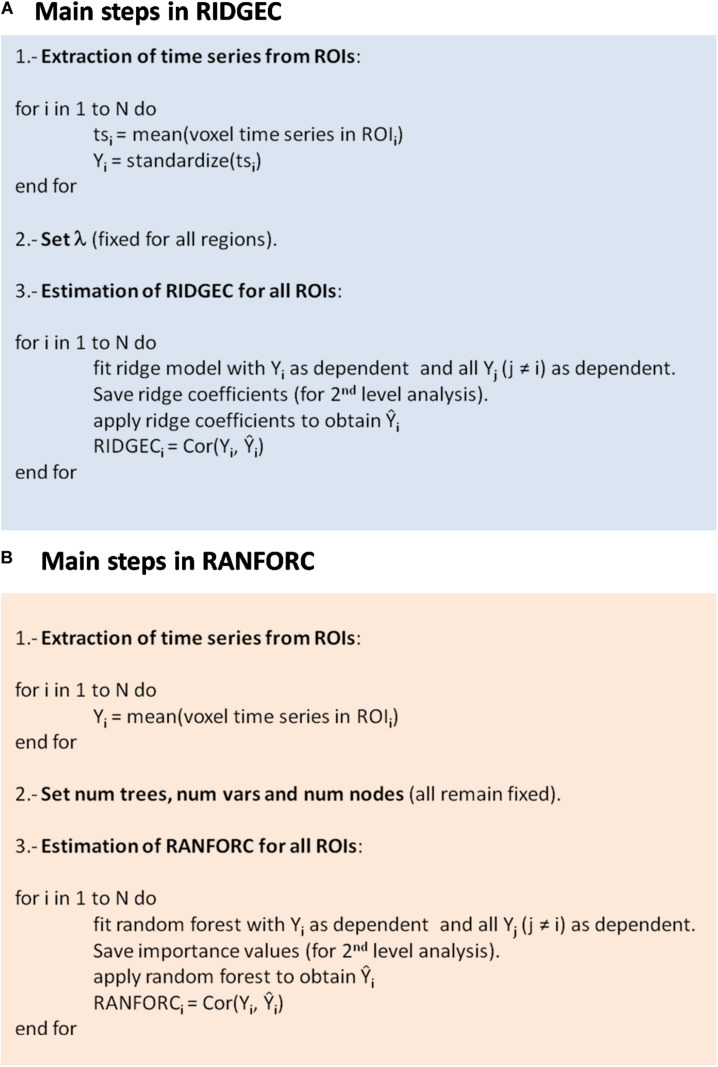
Workflow listing the major steps required to calculate (A) ridge based connectivity values and (B) random forest connectivity values for each one of the N regions extracted from an fMRI preprocessed dataset. Saving ridge regression coefficients and importance values are optional.